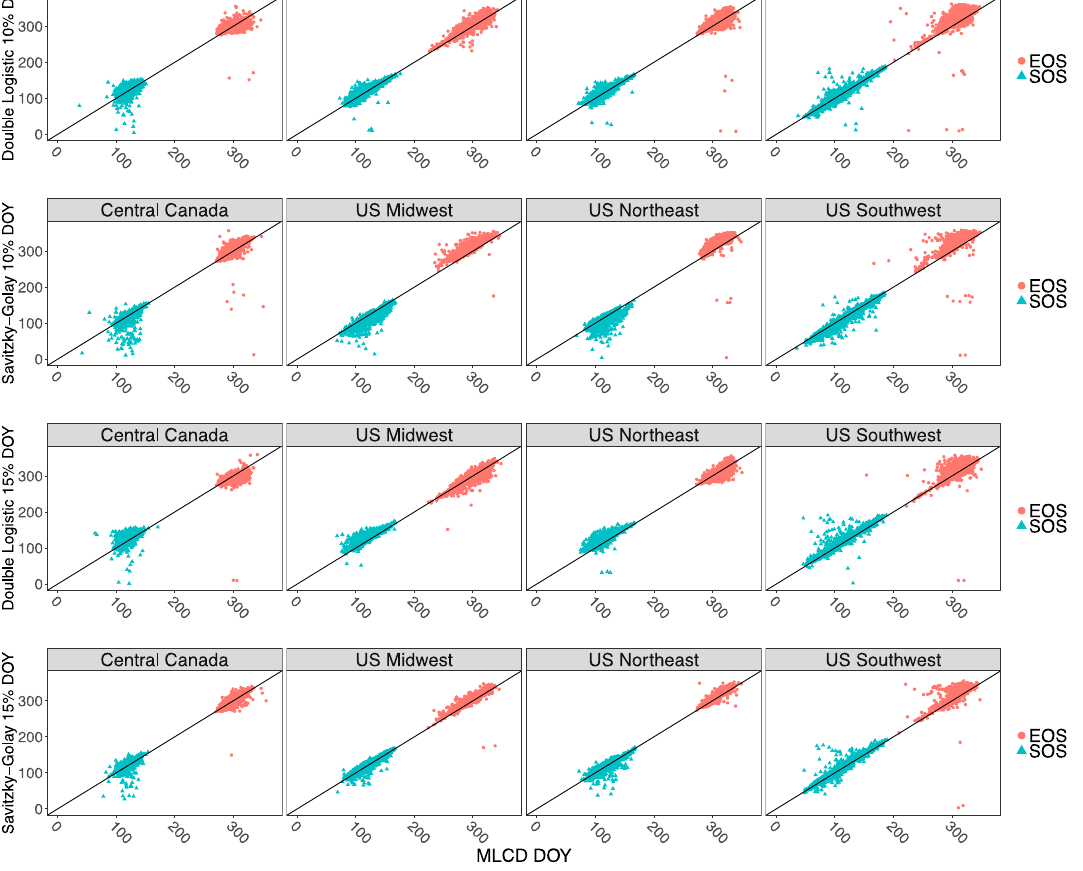
Figure 4. Scatterplots showing agreement among the MLCD C6 product and the different TIMESAT approaches stratified by season: start of season (SOS) is shown in blue and end of season (EOS) is shown in red. The panels represent the different regions of North America included in this study. Data shown in this plot were screened for snow using normalized difference snow index (NDSI).